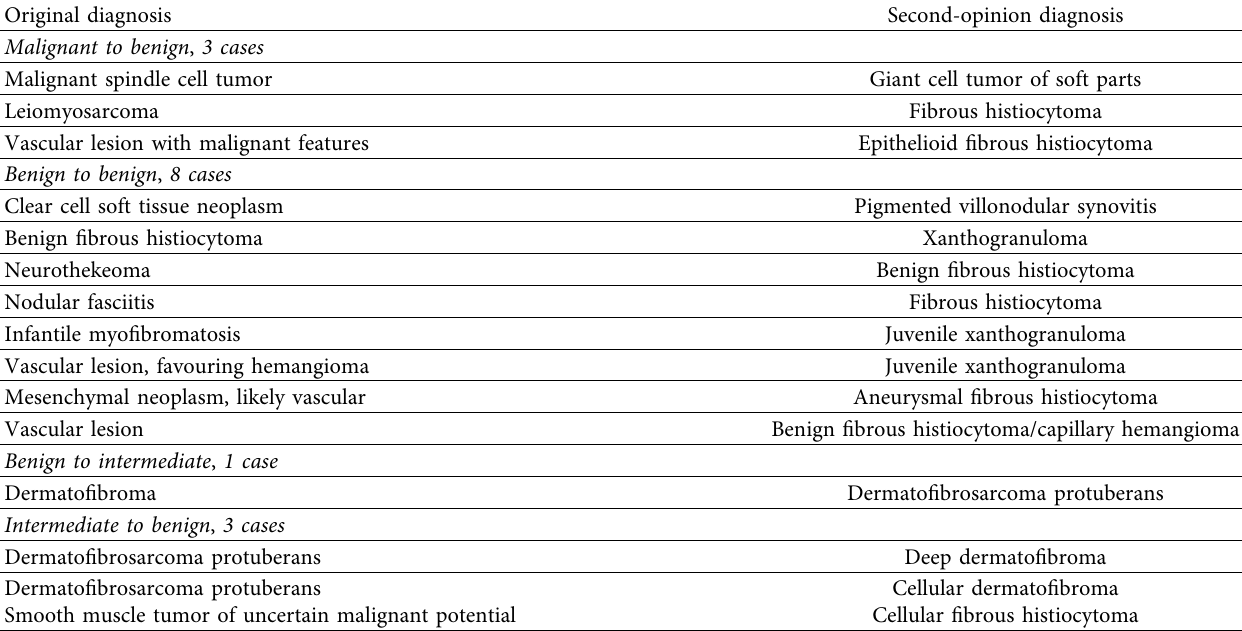
Table 7: Fibrohistiocytic tumors with discrepancy in opinion.